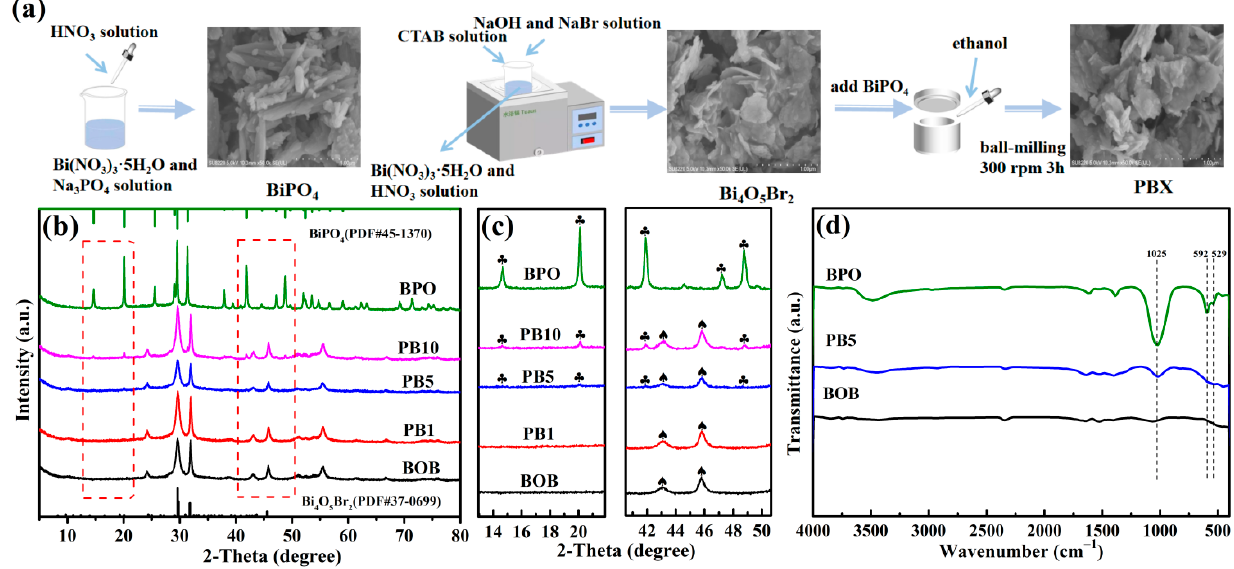
Figure 1. The preparation flow chart of target composites ( a ); XRD patterns of bare BOB, BPO, and PBX series ( b ) and their enlarged images ( c ); FT-IR spectra of BOB, BPO, and composite PB5 ( d ).